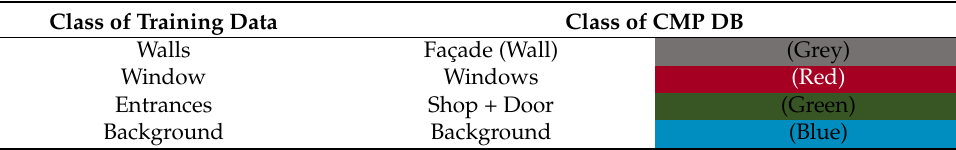
Table 5. Class of training data.